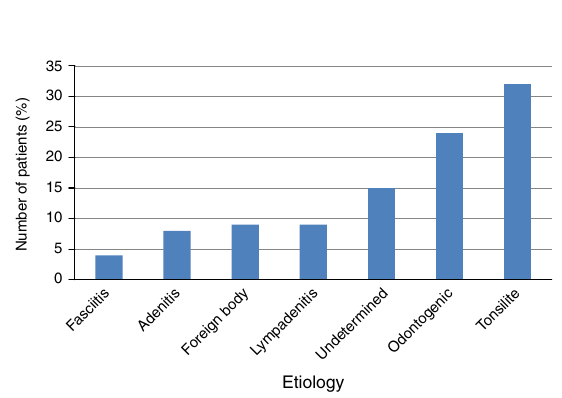
submandibular space in 4 patients (14.8%) and the retropha- ryngeal space in 4 patients (14.8%). In adults group, the